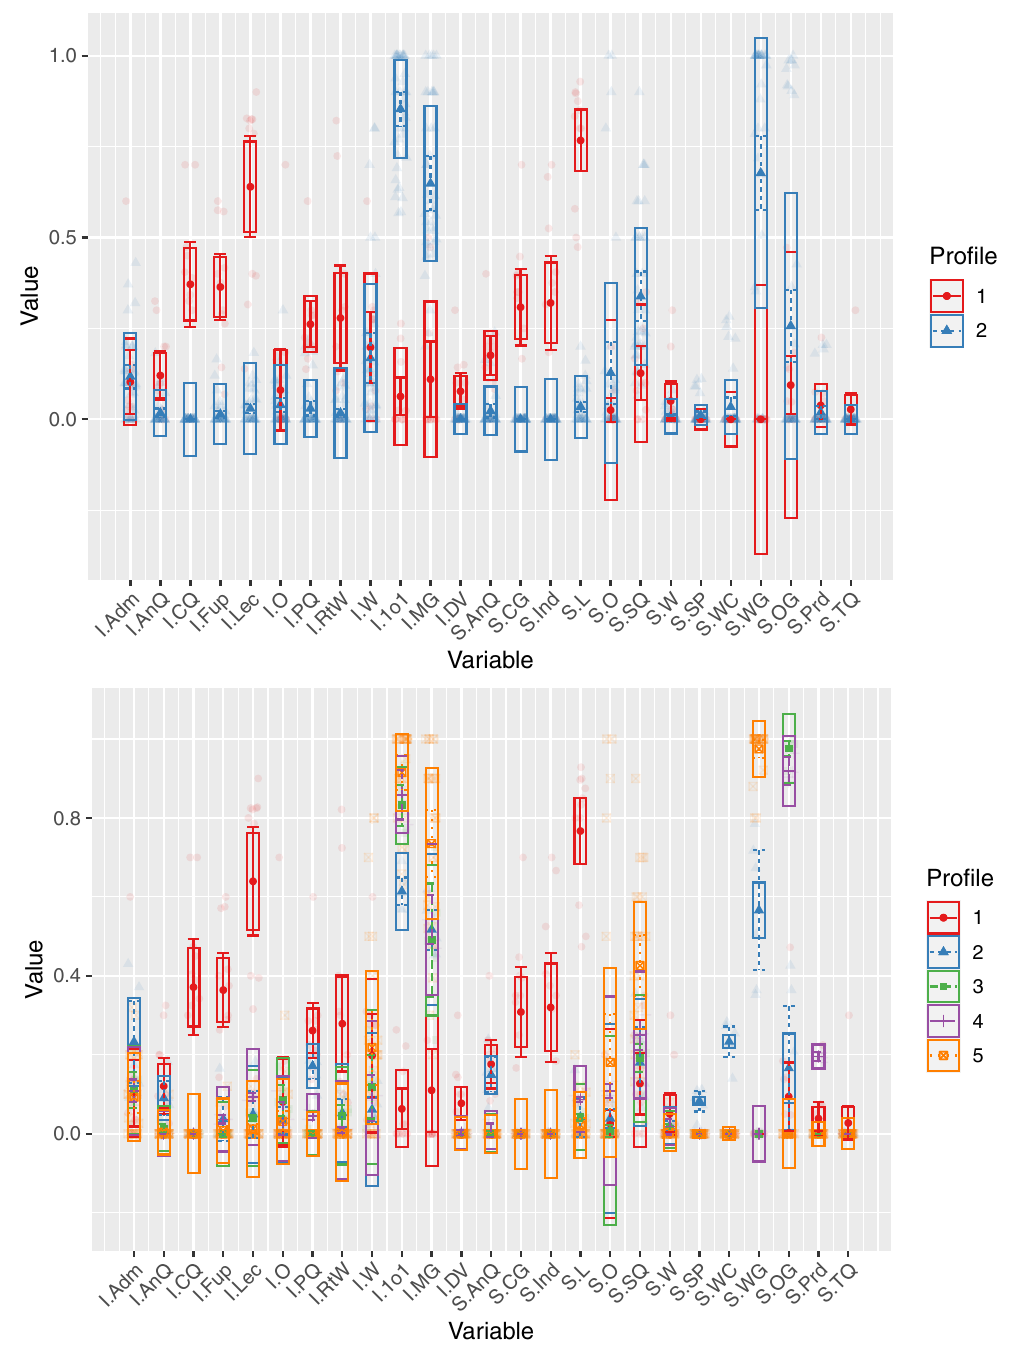
FIG. 3. Model 1 shown for 2 profiles (top panel) and 5 profiles (bottom panel). The x axis shows the full set of COPUS codes included in the analysis, while the y axis shows the fraction of class time dedicated to that code. The light shaded dots show the actual COPUS profiles, colored by their assigned profile. The boxes show the standard deviation in each assigned profile, and the bars show the confidence interval of the centroid of said profile assignment. Since we used the equal variance model, the size of the boxes is equal between classes in each COPUS